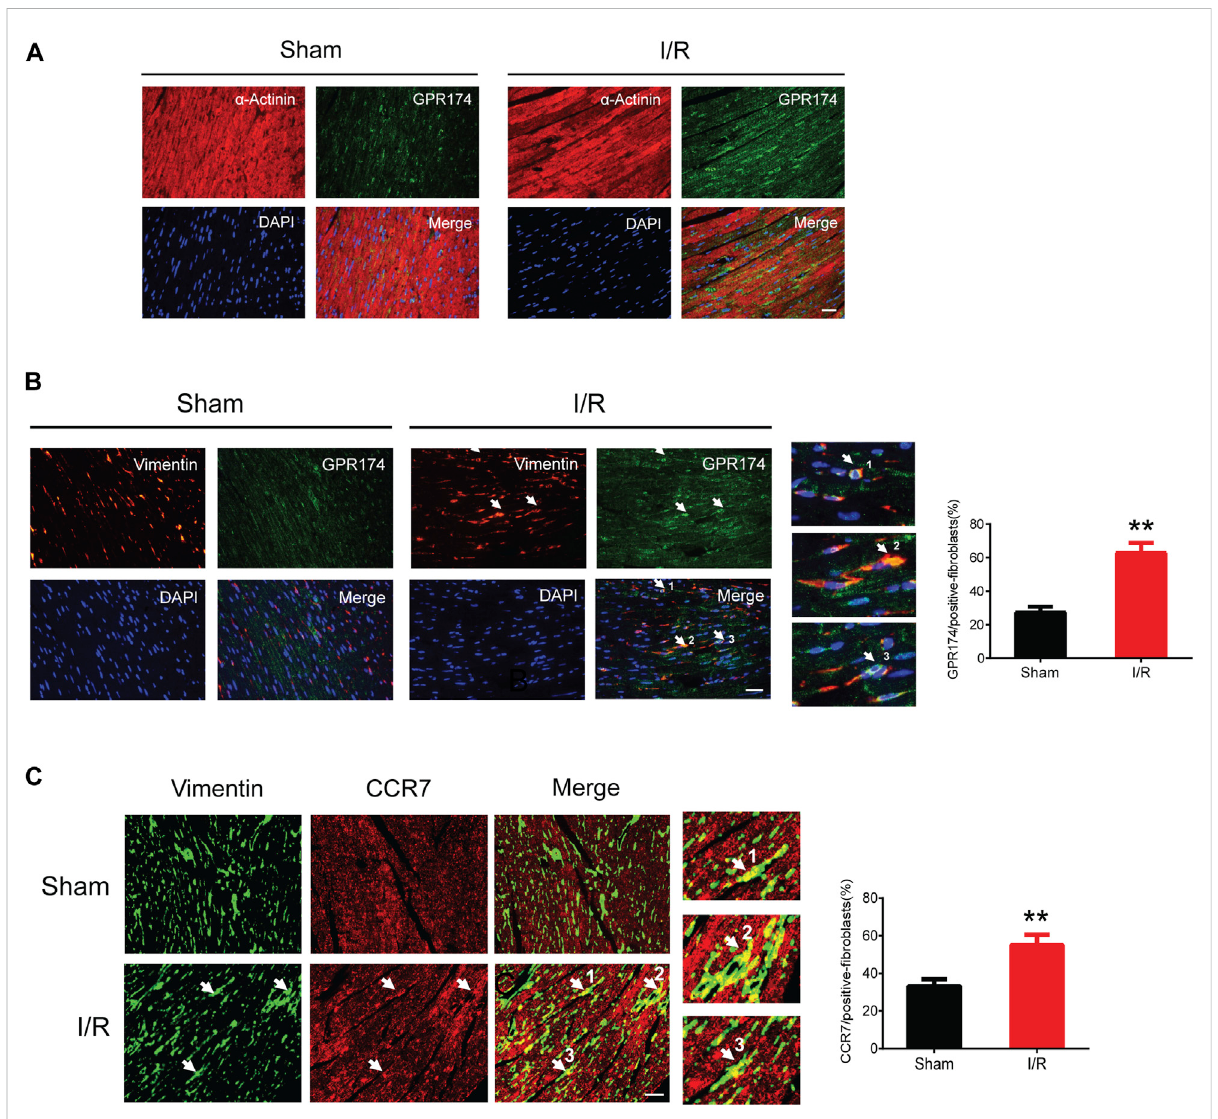
FIGURE 7 Expression ofGPR174 and CCR7 oncardiac fi broblasts during myocardial I/R injury. (A) Immuno fl uorescence stainingshowingthat GPR174 did not present on cardiomyocytes in the sham or I/R groups. (B) Immuno fl uorescence staining showing the expression of GPR174 on cardiac fi broblasts. (C) Immuno fl uorescence staining showing the expression of CCR7 on cardiac fi broblasts in the sham and I/R groups. Scale bar = 50 μ m n = 3. ** p < 0.01 vs. the sham group. I/R, ischemia